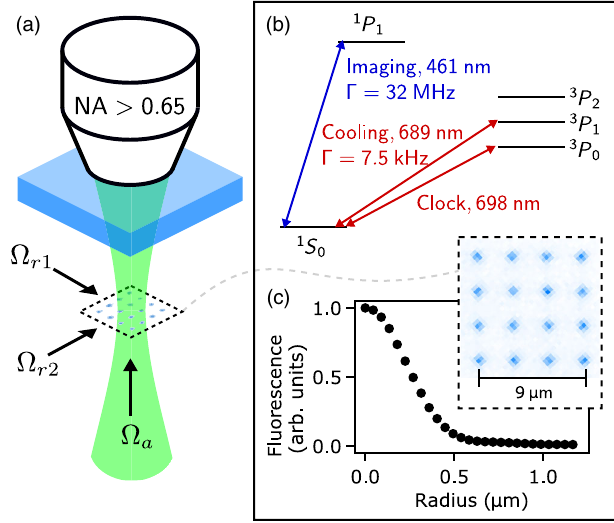
FIG. 1. (a) Apparatus for microscopic control of arrays of strontium atoms. We use a high numerical aperture (NA > 0 . 65 ) objective to focus 515-nm light into arrays of optical tweezers in which we trap and manipulate individual strontium atoms. (b) Strontium atoms have transitions with a wide range of linewidths, which are useful for imaging ( 1 S 0 to 1 P 1 ), cooling ( 1 S 0 to 3 P 1 ), and for optical frequency metrology ( 1 S 0 to 3 P 0 ). In this work we probe the cooling transition in the axial direction with beam Ω and in two near-orthogonal radial directions with a beams Ω . (c) Point spread function (PSF) from single atoms r 1 ;r 2 in our optical tweezers, corresponding to an effective Gaussian waist of 0 . 44 ð 2 Þ μ m (black points). In (a) and (c) averaged atom array images are displayed in the dashed boxes. In this work, we use 3 × 3 or 4 × 4 arrays with a lattice constant of ∼ 3 μ m to ensure that our atoms behave independently. However, our optical system is compatible with substantially larger arrays with tighter spacings (see Appendix